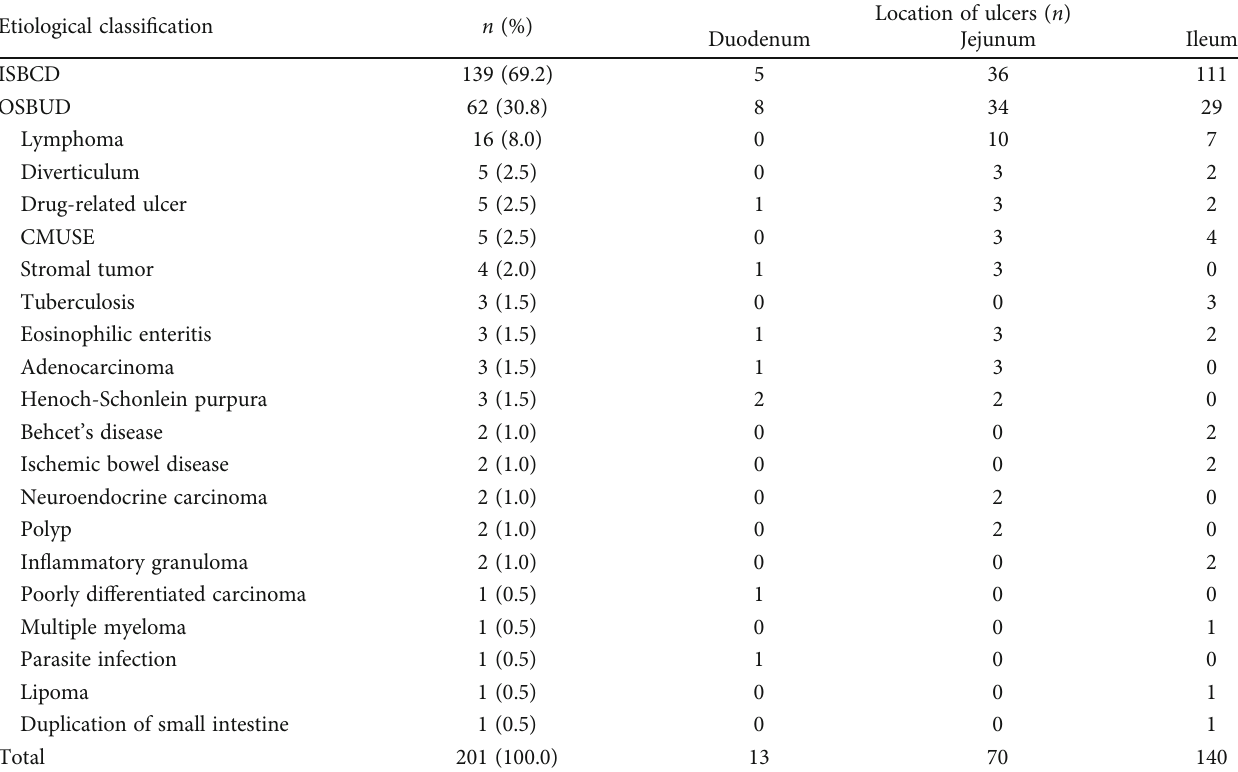
Table 1: Etiological classi fi cation and ulcer distribution of the 201